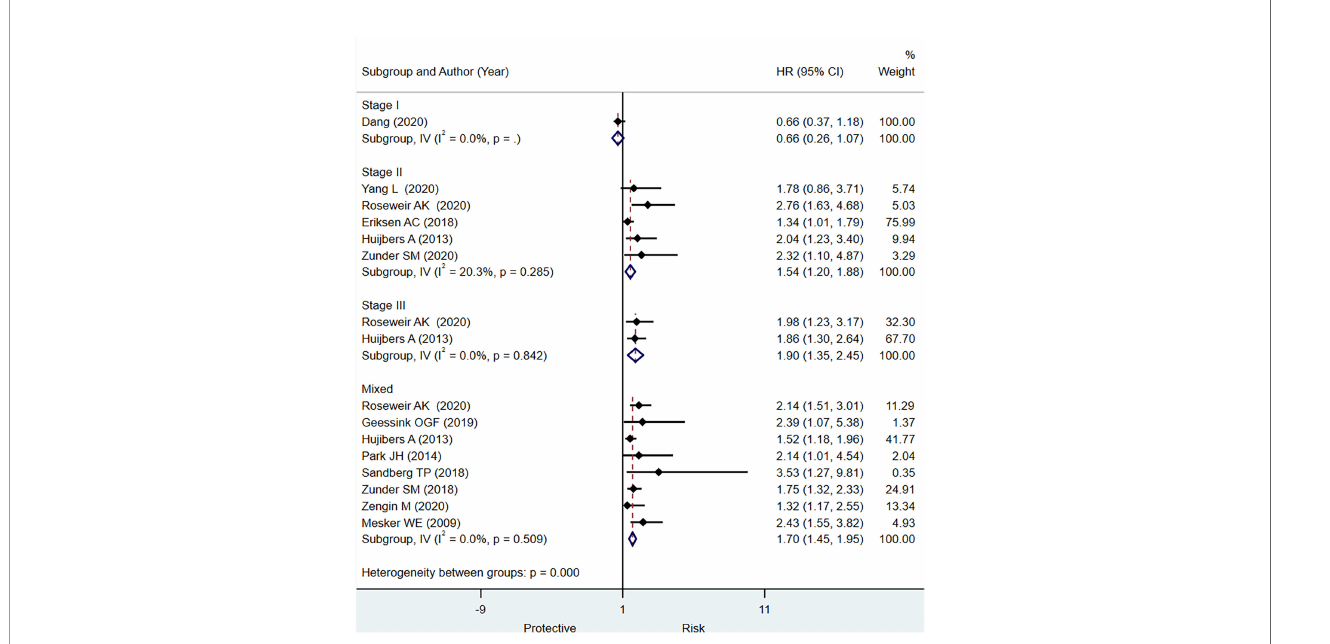
FIGURE 3 | Pooled hazard ratio for different stages of colorectal cancer (CRC) for predicting disease-free survival.